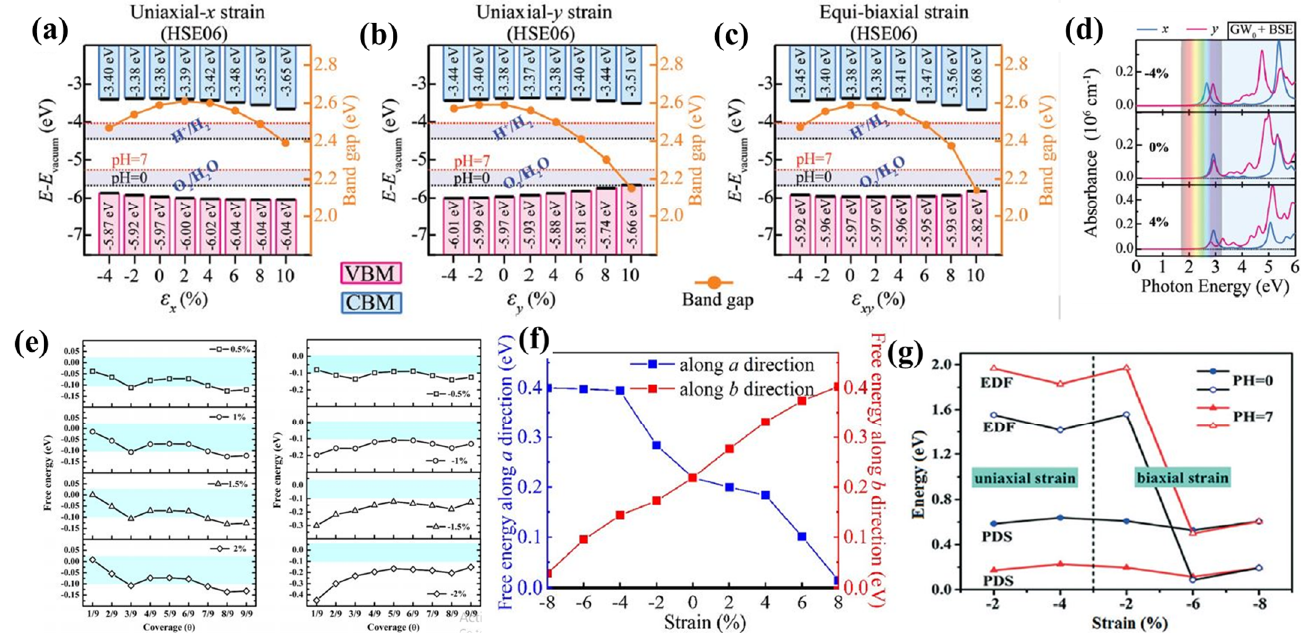
Figure 8. The variation of the band edge position of the VBM (depicted as pink bars) and CBM (depicted as sky blue bars) and band gap energy (depicted as orange points with orange line) computed using the HSE06 functional for h-AlN monolayer with respect to ( a ) uniaxial-x ( b ) uniaxial-y, and ( c ) equi-biaxial strains. ( d ) Variation of optical absorbance coefficient with respect to equi-biaxial strain computed using GW0 + BSE approximation. Reprinted with permission from ref. [179]. Copyright 2021 RSC. ( e ) Variation of the free energies of hydrogen adsorption with applied biaxial strain. The free energy with catalytic activity comparable to that of Pt is highlighted in light blue. Reprinted with permission from ref. [182]. Copyright 2020 ACS. ( f ) The hydrogen adsorption free energy of Cu@Sb under strain from −8% to 8%. Reprinted with permission from ref. [165]. Copyright 2020 Elsevier. ( g ) The EDF and PDS of uniaxial and biaxial strained WS2/BlueP during OER at PH = 0 and PH = 7. Reprinted with permission from ref. [166]. Copyright 2021 RSC.